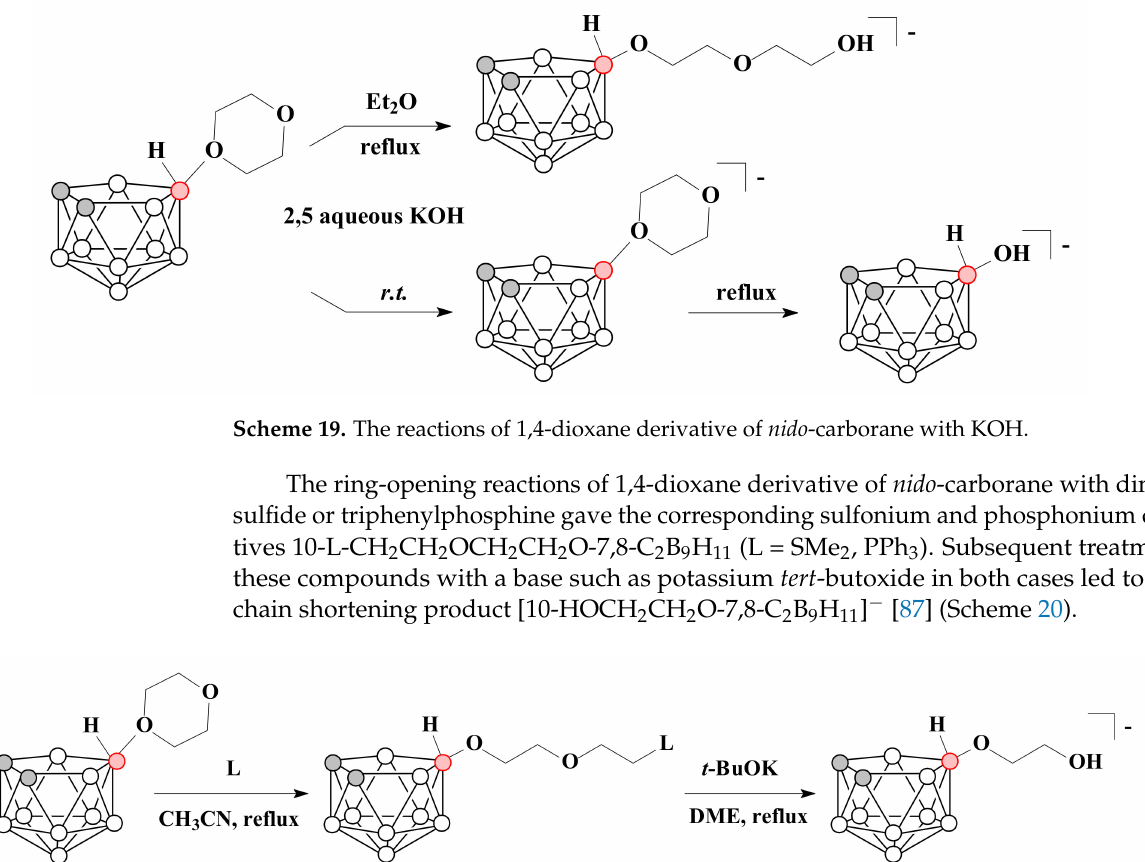
by single crystal X-ray diffraction [88] (Figure 5).